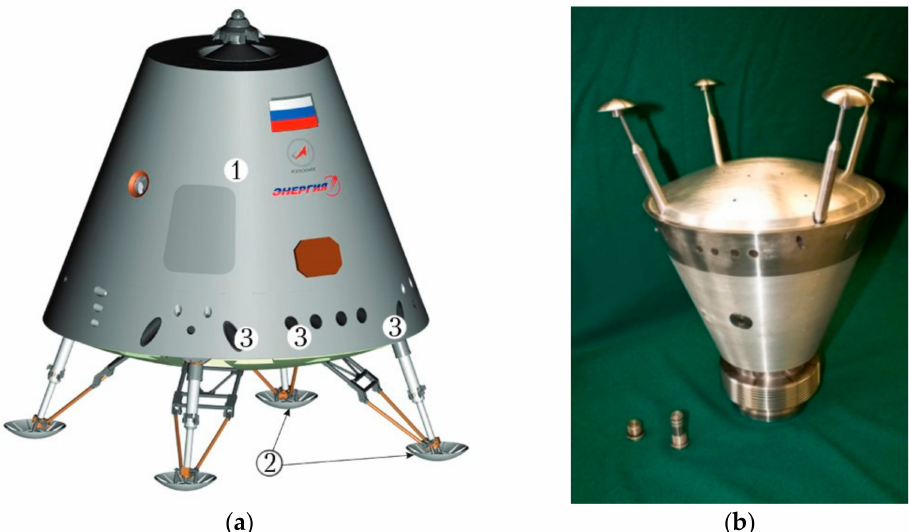
Figure 1. A mockup Future Technology-Manned Transportation Spacecraft (cosmolenta.com) ( a ) being developed by the Korolev Rocket and Space Corporation Energia, Korolev, Moskovskaya Oblast, Russia (the digit 3 denotes the nozzles of landing retro-rockets and rocket engines intended for the compensation of lateral wind loads), and the small-scale model (in inverted position) intended for use in tests to be performed at the jet facility in cold air (Khristianovich Institute of Theoretical and Applied Mechanics, Siberian Branch of the Russian Academy of Science, ITAM SB RAS) ( b )